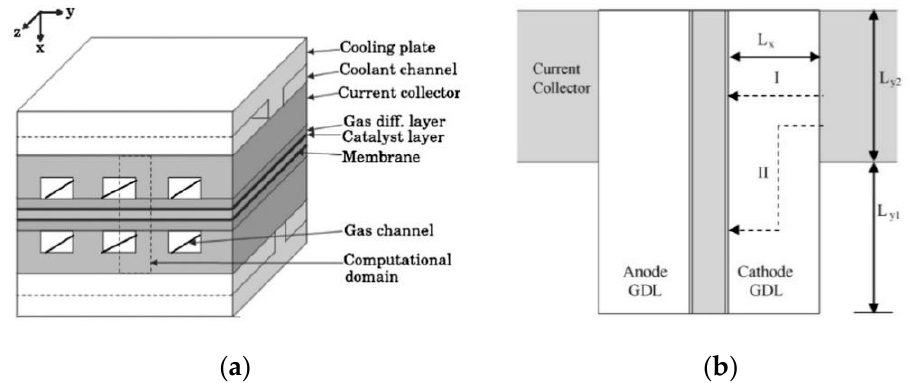
Figure 3. Schematic representation of computational domain of a PEMFC ( a ) and transport of electrons in a GDL ( b ) [20].